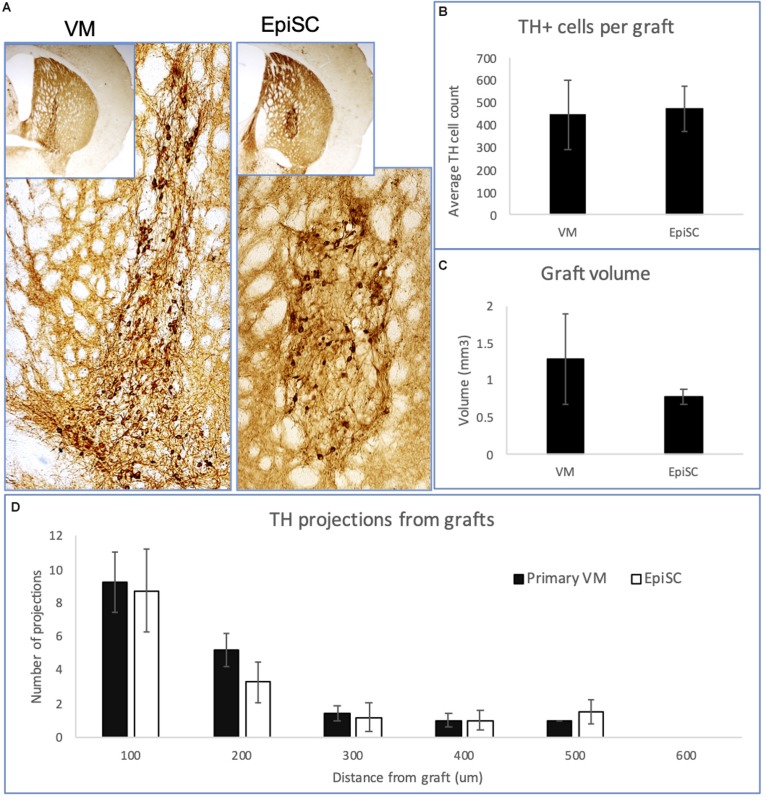
Expression of TH in transplants of VM and EpiSC derived DA progenitors at 16 weeks post-transplantation. (A) Photomicrographs of histological sections from mouse brains transplanted with VM derived DA progenitors and EpiSC derived DA progenitors, showing TH immunoreactivity. Higher magnification images reveal TH immune-positive cells within the grafts. Bar charts showing: (B) the average number of TH immuno-positive cells per graft; (C) the graft volume; and (D) the number and distance of TH projections. Error bars represent standard error of the mean.